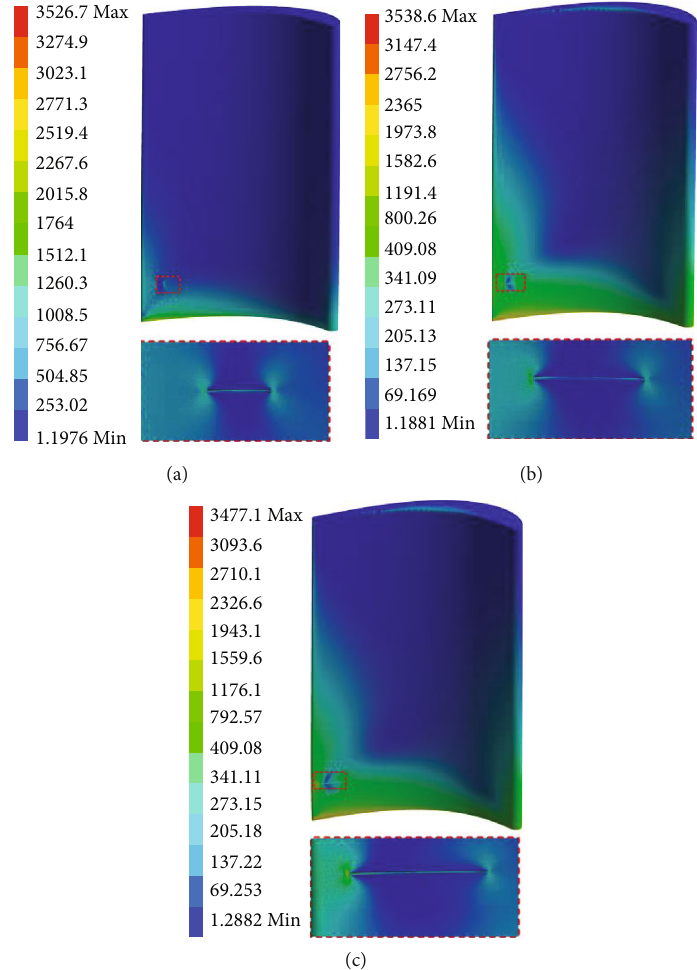
Figure 20: The stress distributions of blades with surface cracks. (a) 2mm. (b) 4 mm. (c) 6